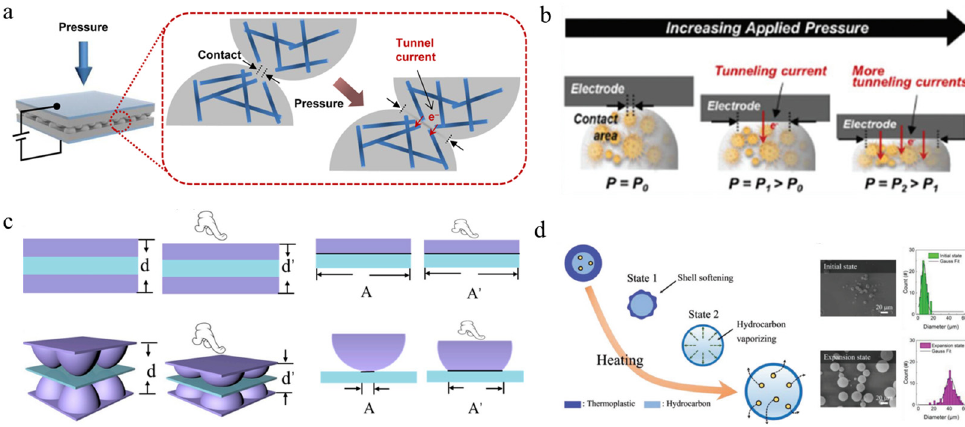
Figure 3. Schematic of microdome array-based pressure sensor. ( a ) Schematic of the working principle for interlocked microdome arrays with conductive nanofiber inside. Under pressure, the deformation of the micro dome increases the contact area and tunneling current of nanofibers [115]. ( b ) Schematic of microdomes composed of metal nanoparticles under pressure [116]. ( c ) Schematic diagram showing the difference in distance and contact area between film and microdome array under pressure [117]. ( d ) Thermal expansion of microdome with irregular structure under applied temperature [118].